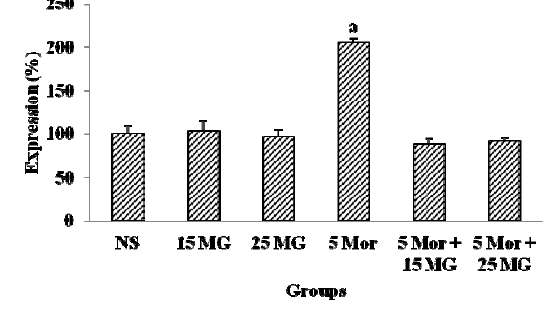
Figure 4. The expression of CREB protein of control group (normal saline), mitragynine (15 mg/kg, 25 mg/kg), morphine (5 mg/kg) and combination groups (5 mg/kg Mor + 15 mg/kg; 5 mg/kg Mor + 25 mg/kg) for 9 days treatment. Each column represents the percentage expression of CREB protein (n = 7). Values are statistically siginficant at p < 0.05. a: Morphine treated group compared with control group. Bands were detected via chemiluminescence and Image J analysis and results were expressed in percentage